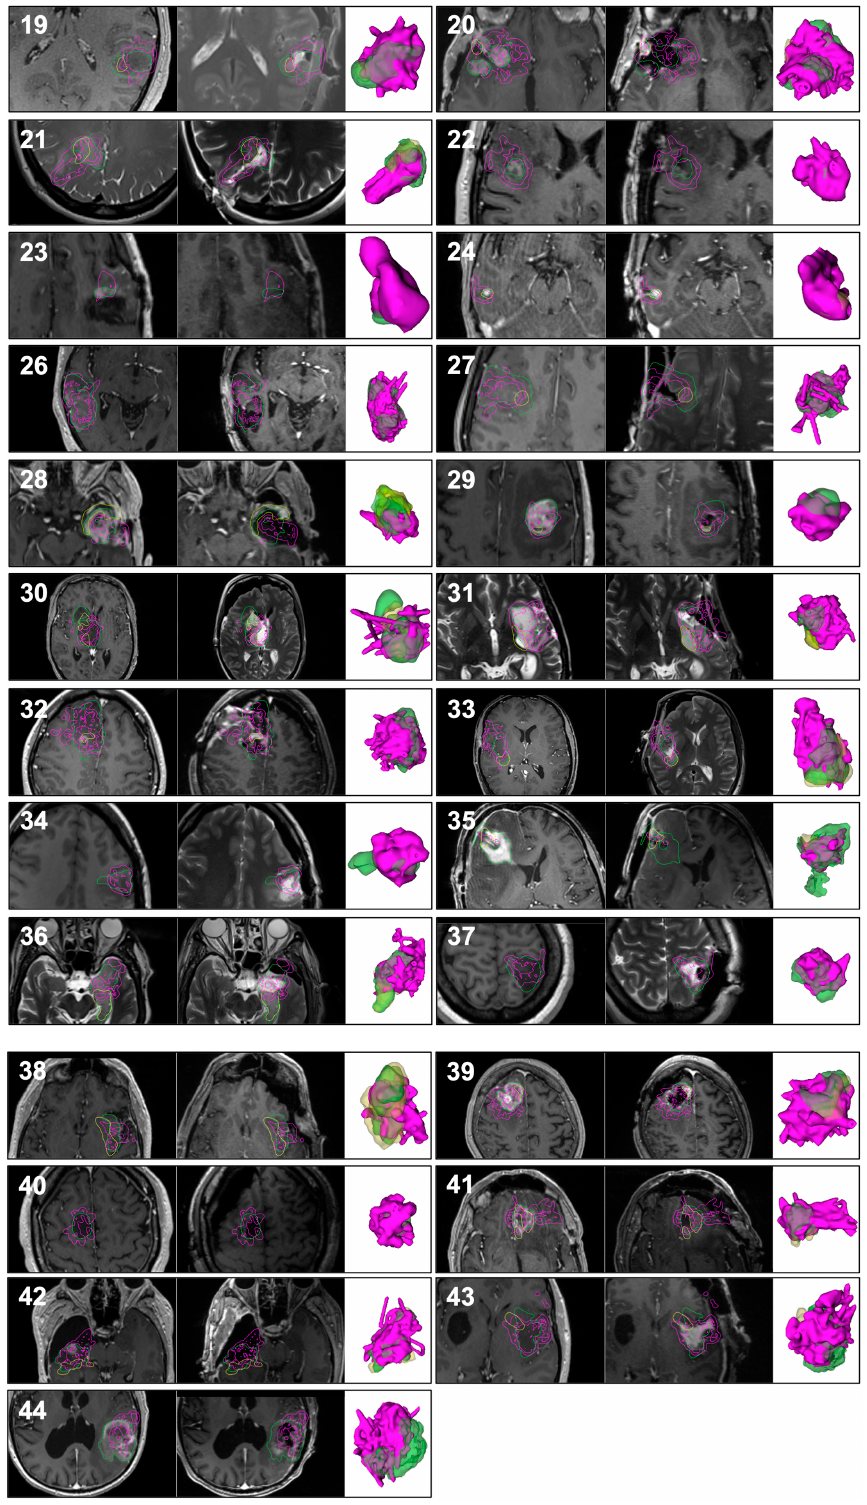
Figure A1. Images of all clinical cases (1 to 44) showing, from left to right and for each case, the preoperative MRI, intraoperative MRI, and 3D models of the tumor segmented on preoperative MRI (green), residual tumor segmented on intraoperative MRI (yellow), and the volume traced out by the tracked tool-tip positions of surgical instruments (pink). The contours of the models are also shown in the MR images by their respective colors. Please note that the orientation of the 3D models bears no relation to the orientation of the MR image slices.